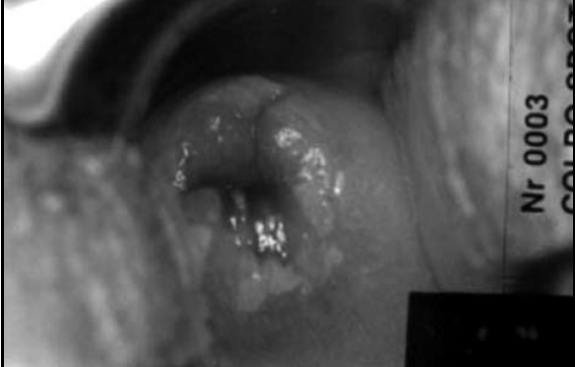
Figura 1 – Imagem cervicográfica de condiloma imaturo (caso 1): lesão micropapilomatosa em lábio anterior e epitélio acetobranco em lábio posterior do colo uterino